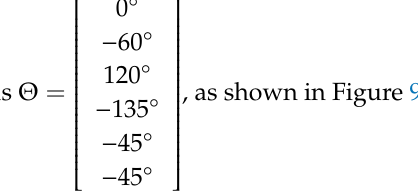
Figure 9. ( a ) Robot in its initial position from the front. ( b ) Robot in its initial position from the side.